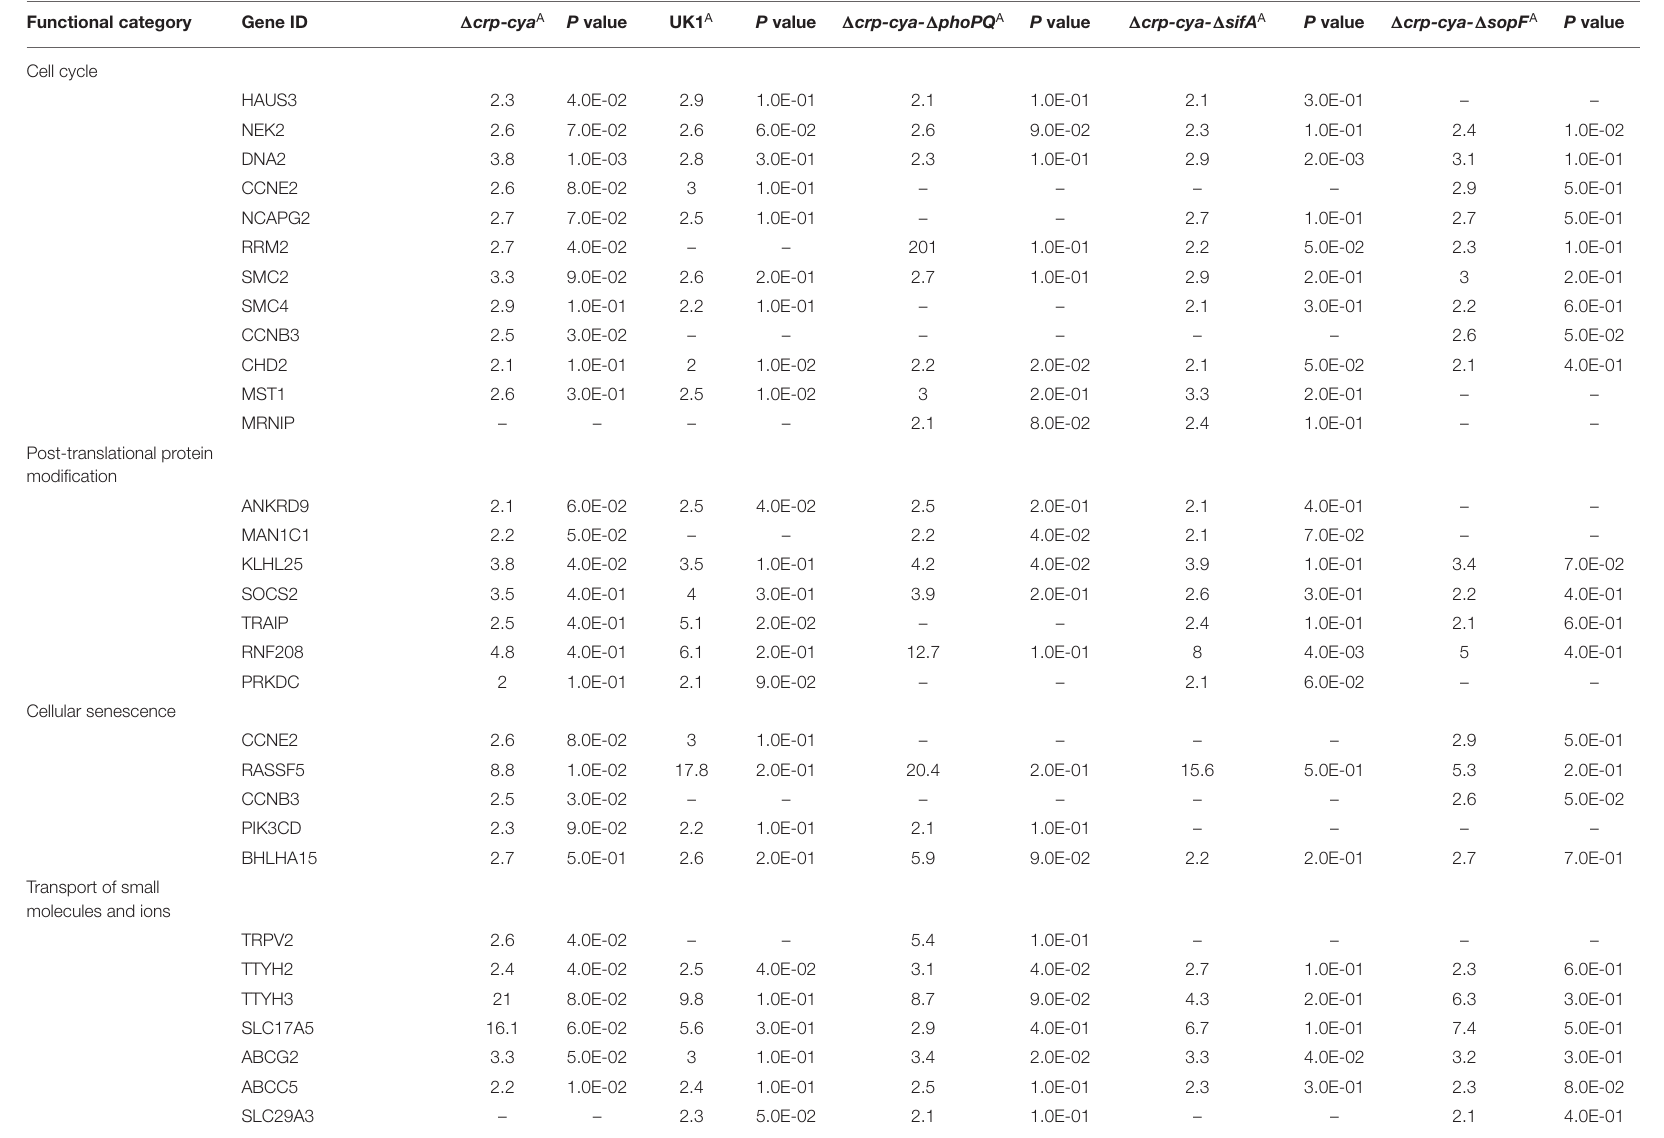
TABLE 4 | Genes downregulated in primary macrophages infected with S. Typhimurium UK1, 1 crp-cya, 1 crp-cya- 1 phoPQ, 1 crp-cya- 1 sifA and 1 crp-cya- 1 sopF